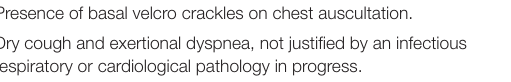
TABLE 3 | Check list of red flags sign or symptom suggestive of ILD. Presence of basal velcro crackles on chest auscultation.